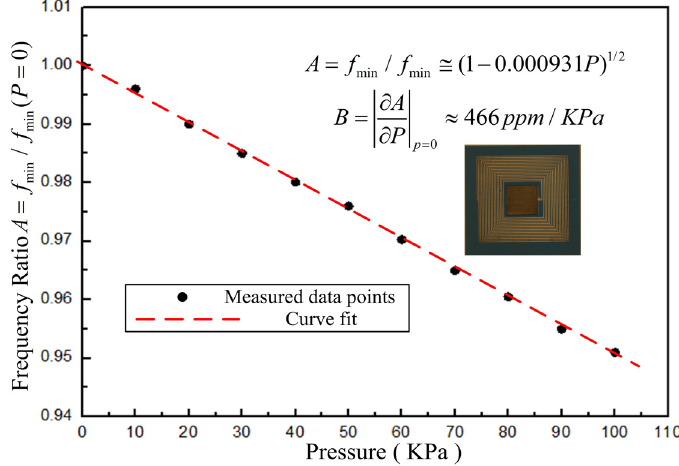
Figure 11. Relative change in sensor’s resonant frequency versus